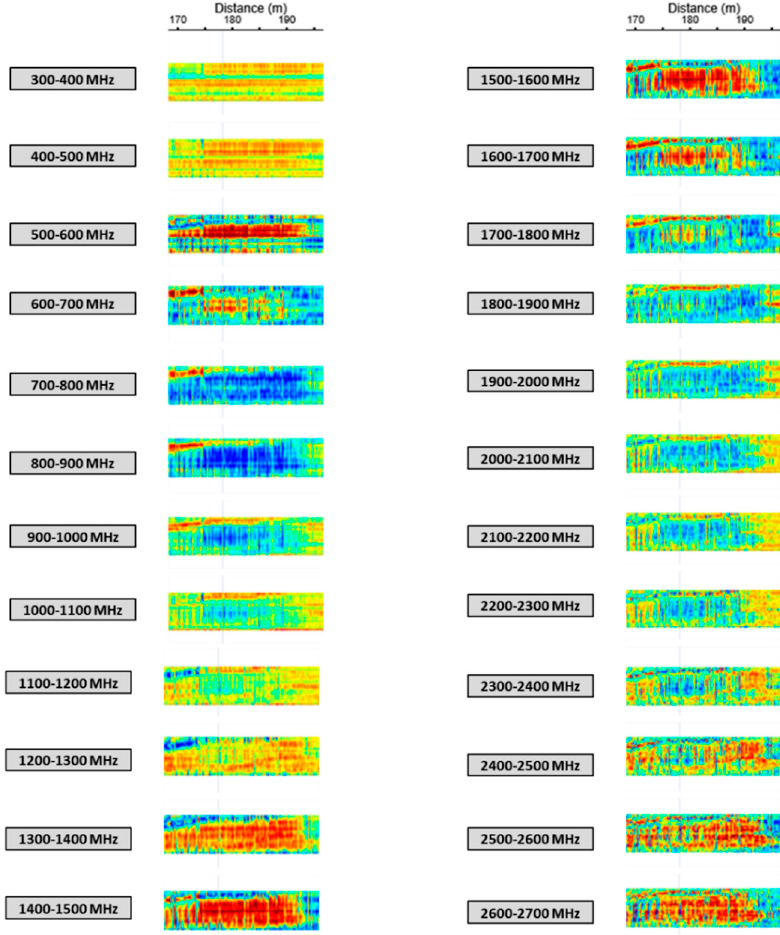
Figure 12. GPR slice with varying frequency, highlight on Area 3.